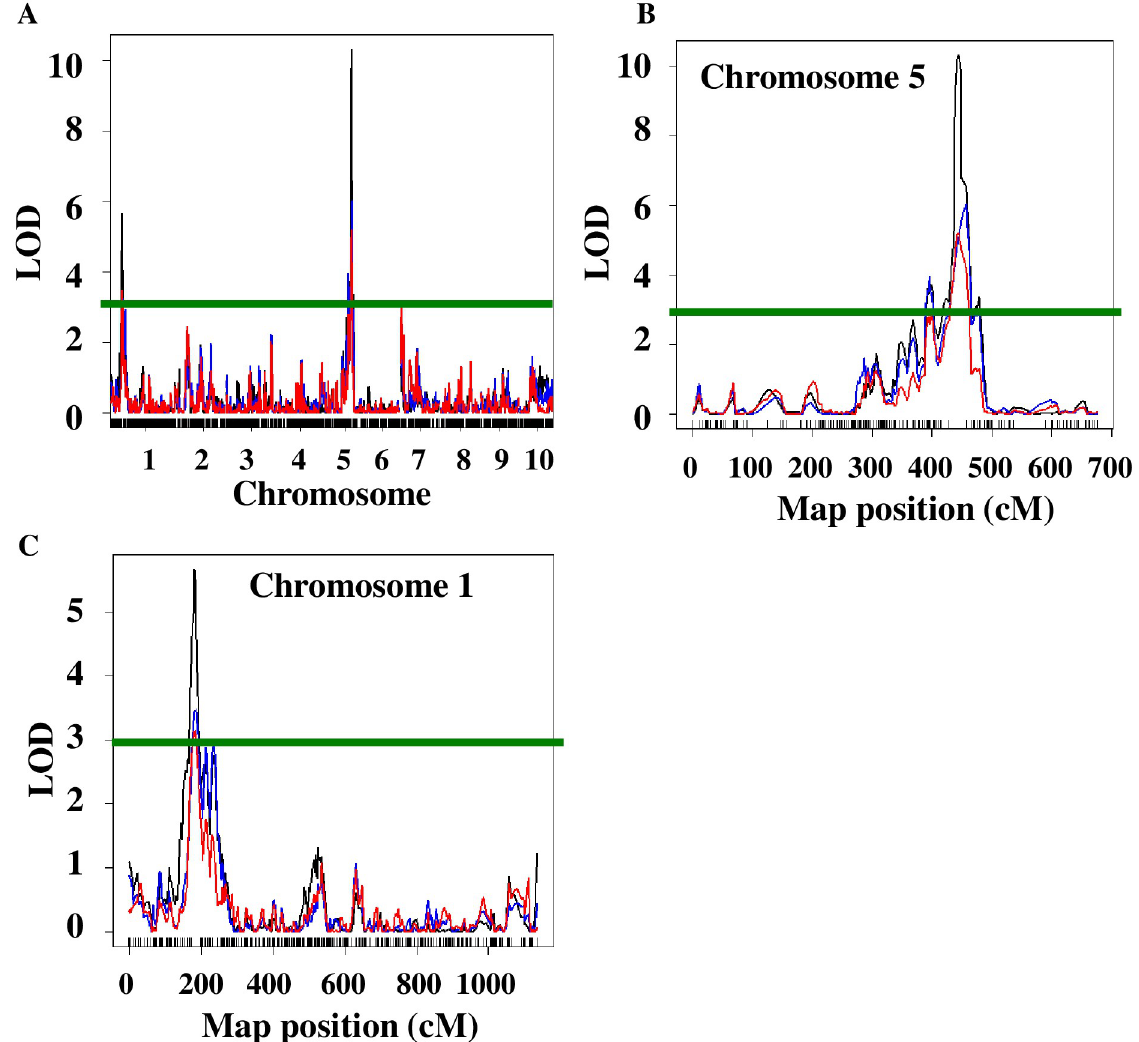
Fig 3. Profiles for QTLs for response to low temperature in maize seedlings in IBM Syn 4 population. LOD score of 3.0 (green line) was used as a cutoff to determine the statistical significance of discovered QTLs. The location of QTLs across the genome (A) or on chromosomes 5 (B) and 1 (C) are shown for various approaches used to measure plant response to cold temperature. The QTL profile determined using visual tolerance score is shown in black, using the proportion of green leaf tissue is shown in blue, while the QTL profile determined by absorbance at 645 nm is shown in red. The QTL profile determined using absorbance at 663 nm closely resembles the profile for visual tolerance score and is not shown. The genetic region from B73 background for this QTL had a positive effect on stress tolerance, while the genetic region from Mo17 background for this QTL had a negative effect on stress tolerance. The QTL-1 explained 7.8–16.2% of the phenotypic variation. The LOD score for the QTL on chromosome 5 varied from 5.2 to 10.3 depending on the phenotypic data set. The genetic region from B73 background for this QTL had a negative effect on stress tolerance. The QTL-2 explained 14.8–27.9% of the phenotypic variation. Absorbance at 663 nm directly correlating to chlorophyll a concentration and visual tolerance score resulted in QTLs with larger LOD scores and a higher proportion of phenotypic variation explained. Among 97 IBM RILs, thirteen lines (MO051, MO054, MO068, MO088, MO090, MO105, MO123, MO126,